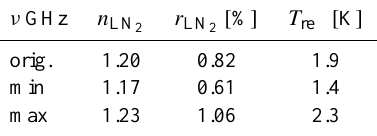
Table 2. Refractive indices ( n LN liquid nitrogen target and the resulting reflective components ( T refl